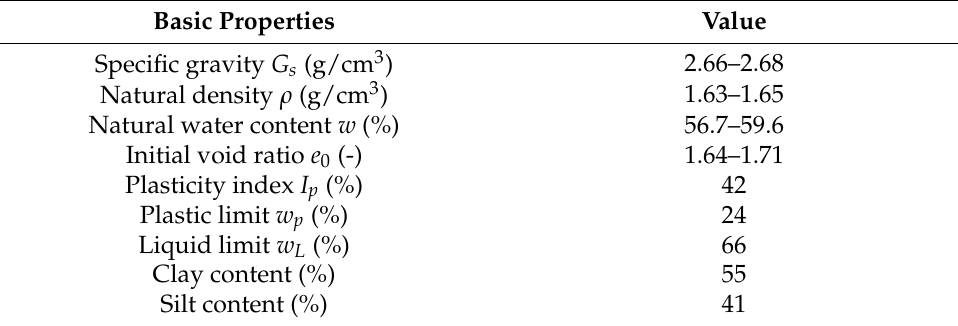
Table 1. Index properties of tested soft